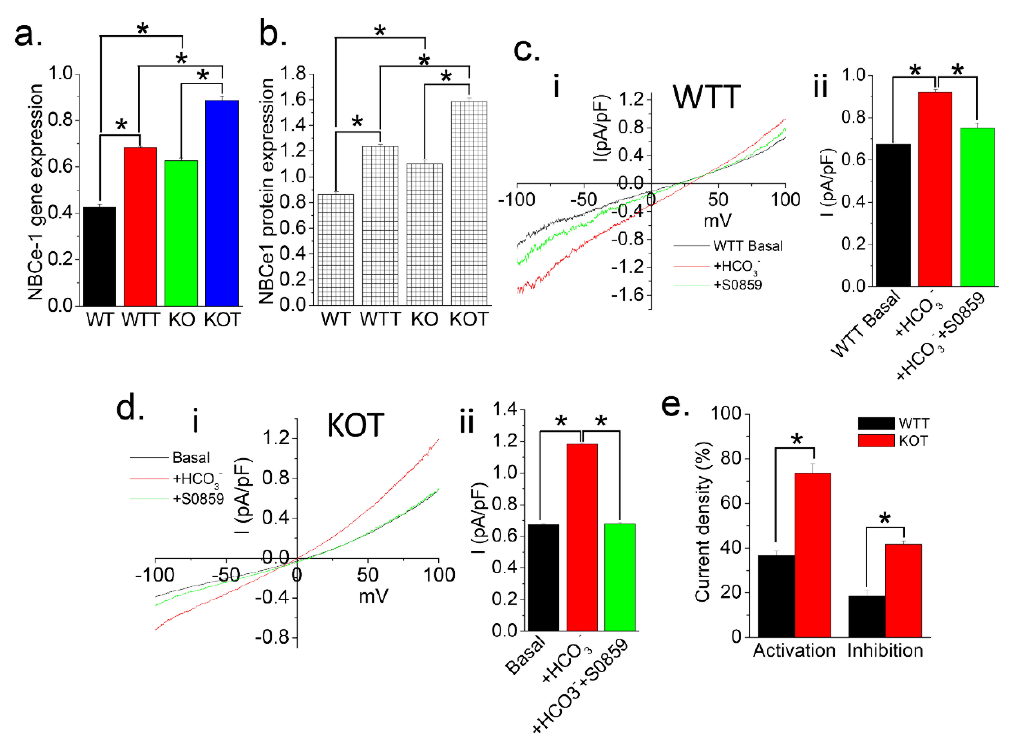
Figure 3. NBCe1 expression and function are enhanced in TRPC3 KO PT cells in higher luminal pH conditions. ( a ) mRNA and ( b ) protein expressions of NBCe1 in PT cells from WT, Acz-treated WT (WTT), TRPC3 KO (KO) and Acz treated TRPC3 KO (KOT) mice were quantitated into bar diagrams. ( c , d ) Whole cell patch clamp voltage sweeps from −100 to +100 mV were quantitated into I-V curves and average current density at +100 mV was calculated. Bicarbonate (0.3 mM) was applied to induce current density and S0859 (50 μM) was applied as a current blocker. ( a , b , ci , cii , di , dii ) NBCe1 gene and protein expression, and average current density at +100 mV were quantitated into means ± SEM, respectively. ( e ) Percentage current density activation (bicarbonate) and inhibition (S0859), respectively, were quantitated into means ± SEM. Experiments were performed four times. *, p < 0.05. Gene and protein expressions are normalized to GAPDH and β-actin respectively.